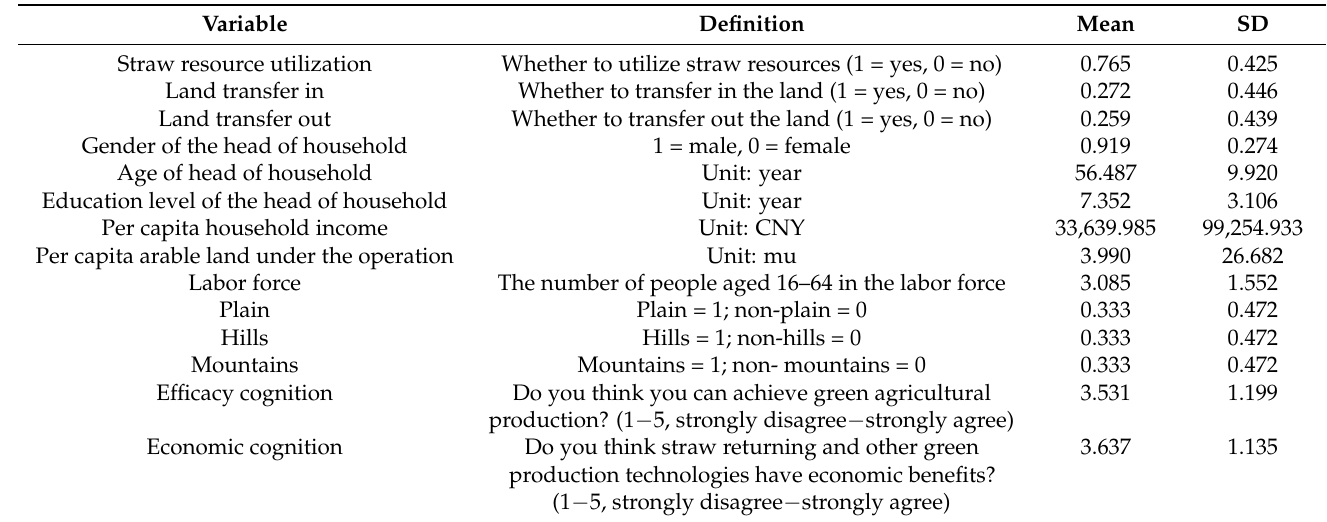
Table 2. Variable settings and descriptive